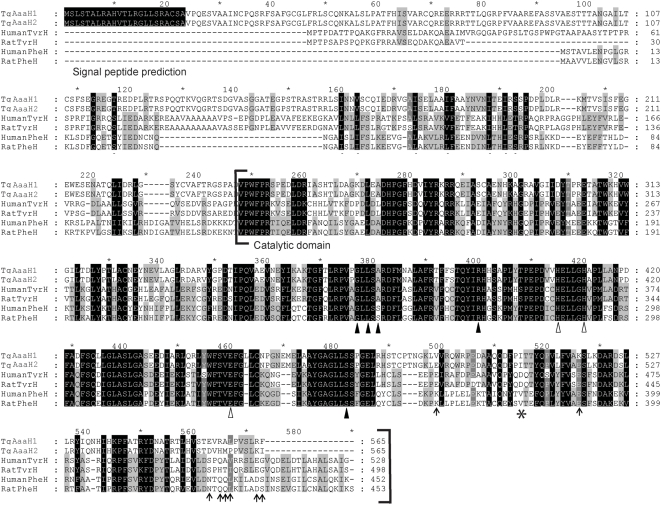
Alignment of aromatic amino acid hydroxylases.Aromatic amino acid hydroxylase sequences from the genes of T. gondii (GenBank™ accession TgAaaH1 – EU481509, TgAaaH2 – EU481510) human TyrH isoform 4 (AAA61179), rat TyrH isoform 1 (AAA42257), human PheH (P00439) and rat PheH (AAA41843). The alignment was generated using MUSCLE alignment software [26]. Identical residues are highlighted in black. The T. gondii proteins appear more similar to mammalian TyrH isoform 4 than isoform 1 [43]. The iron binding residues are highlighted with open triangles. The residues present in the active site that interact with the aromatic amino acid substrate and biopterin cofactor are highlighted with black triangles. The conserved residue implicated in substrate specificity is highlighted with an asterix; D425 encoded by rat TyrH and V379 of rat PheH. Residues that differ between the two T. gondii proteins are highlighted with arrows. The predicted N-terminal signal peptide based on a SignalP (59) prediction is also highlighted. The conserved VPWFPR motif identifies the start of the catalytic domain shown in brackets (61).